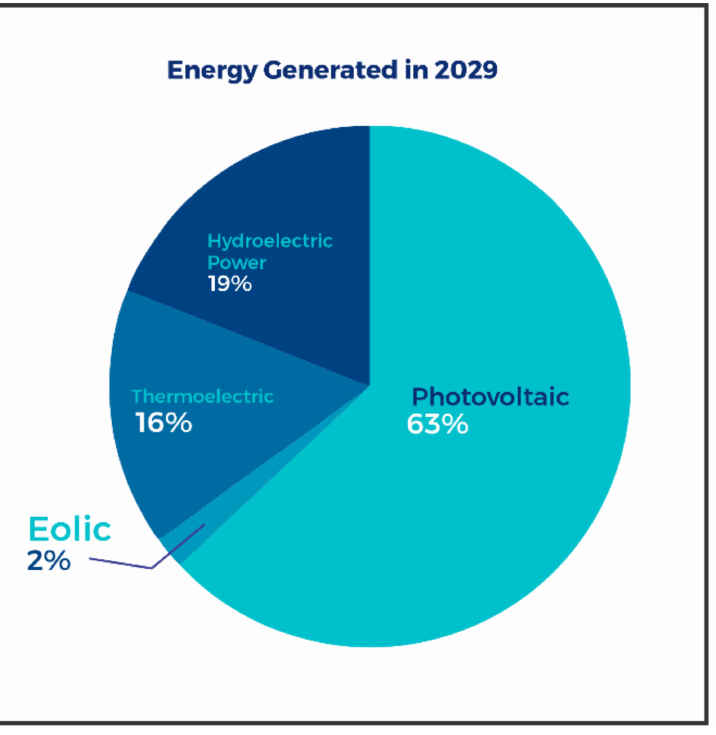
Figure 4. The expectation of generation of electric energy by the Micro and Distributed Mini Generation (MMGD) source, at the end of 2029. Source: Adapted from EPE (2019)